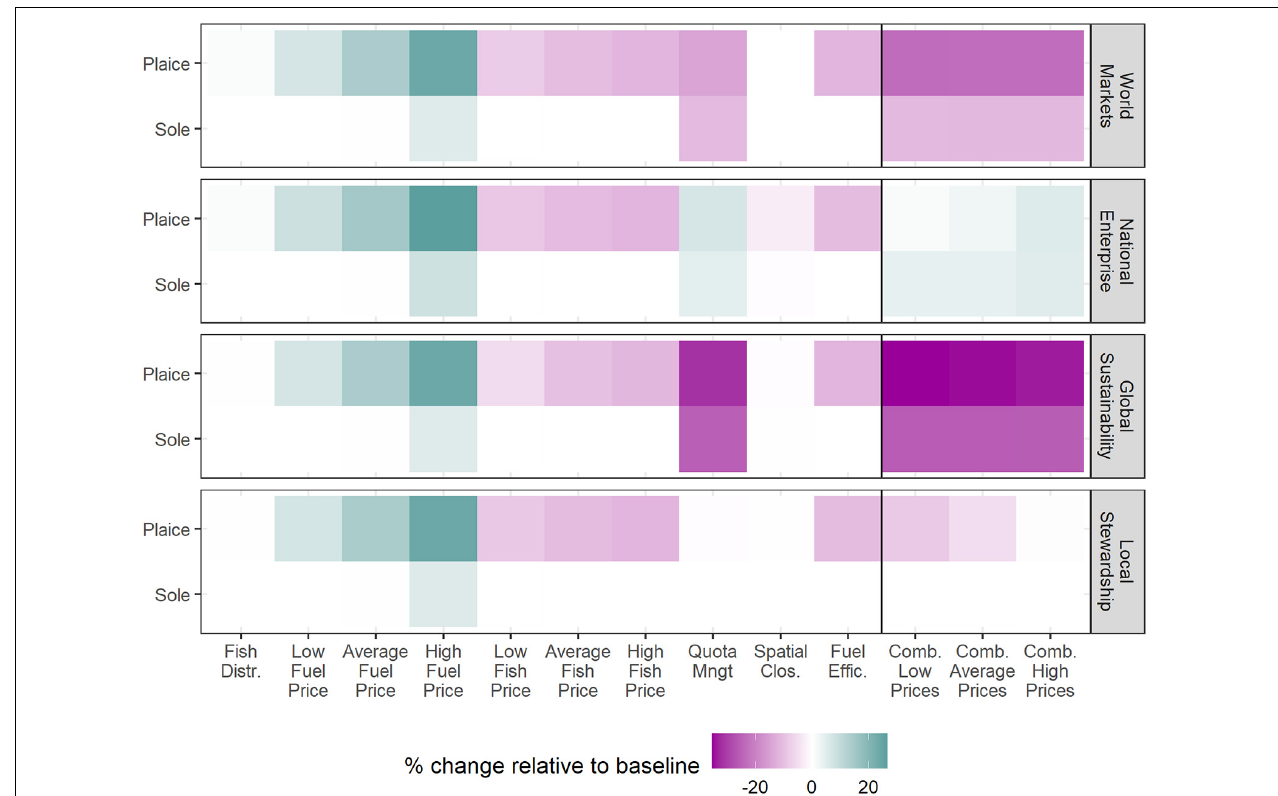
FIGURE 9 | Relative change of potential catch (TAC) of sole and plaice in the mid-century (2040–2050) per fleet per scenario, disaggregated per factor, compared to the baseline. Factors include Fish Distr.: change in species distribution, fuel/fish price: low, average and high fuel/fish price trends as defined in Table 1 , Quota Mngt: different FMSY target to calculate sole and plaice quota and quota trading rules; spatial Clos,: marine spatial planning; Fuel Effic.: increase in fuel efficiency; Comb. Low/Average/High Prices: scenarios combining all the factors with low/average/high fish and fuel prices as defined in Table 1